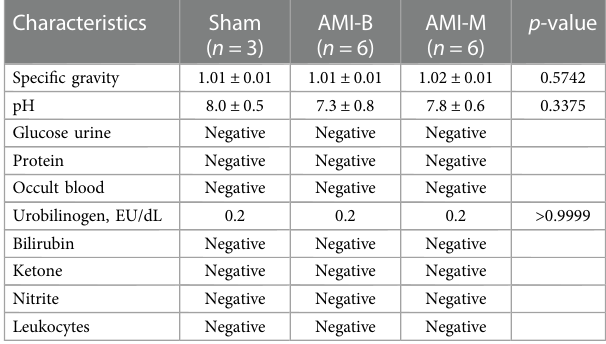
TABLE 5 Urine examination for three groups at